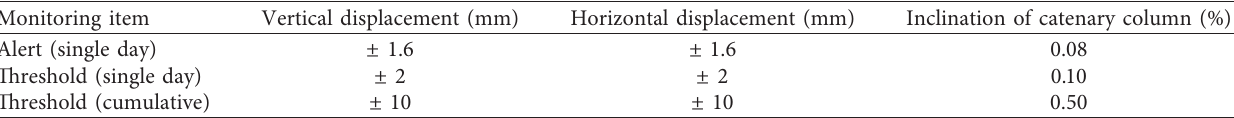
Table 7: Alert and threshold values for the monitoring